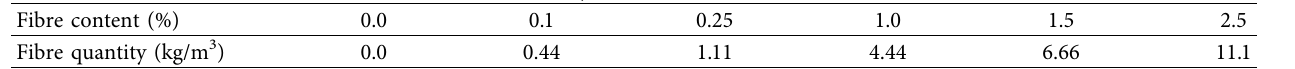
Table 6: Quantity of fibres for various mixes.